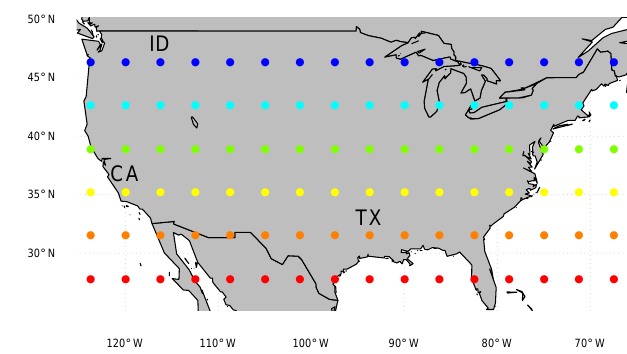
Figure 2. Locations of centers of grid cells for model output used here. The rainbow color scale for latitudes is used throughout this study. Idaho (ID), California (CA), and Texas (TX) grid cells are used as examples in Figs. 6, 10, and